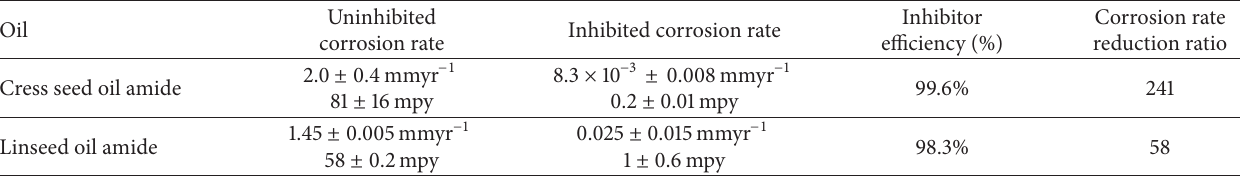
Inhibited corrosion rate